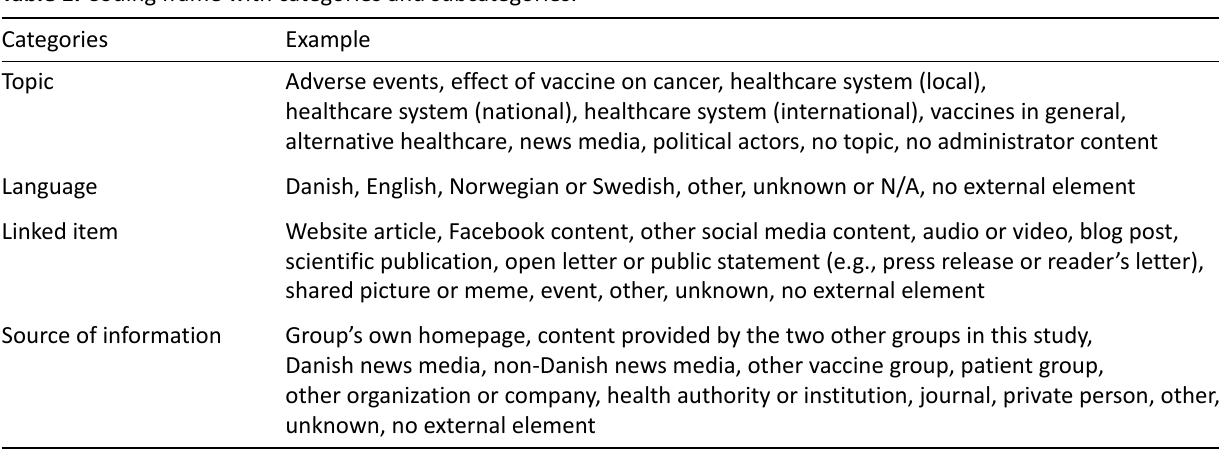
Table 1. Coding frame with categories and